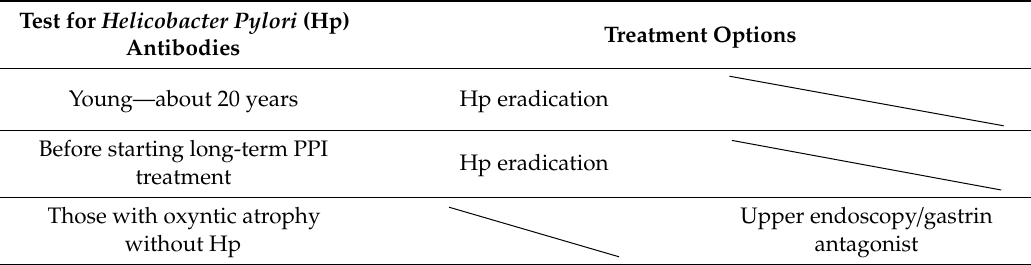
Table 3. Treatment of Helicobacter pylori related gastritis to prevent gastric